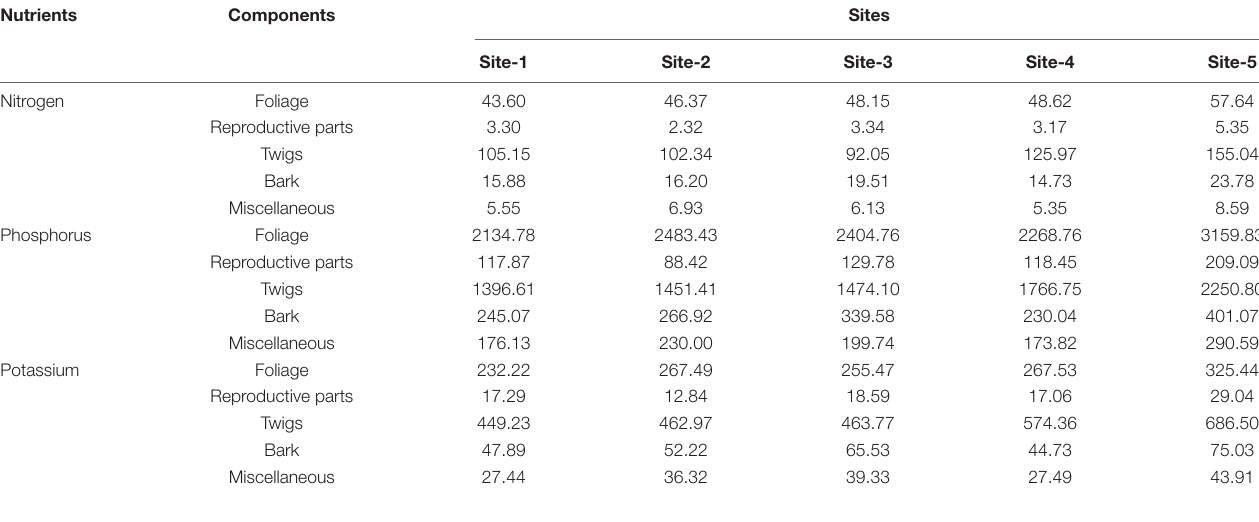
TABLE 10 | Nutrient use efficiency of different components of litter across the selected